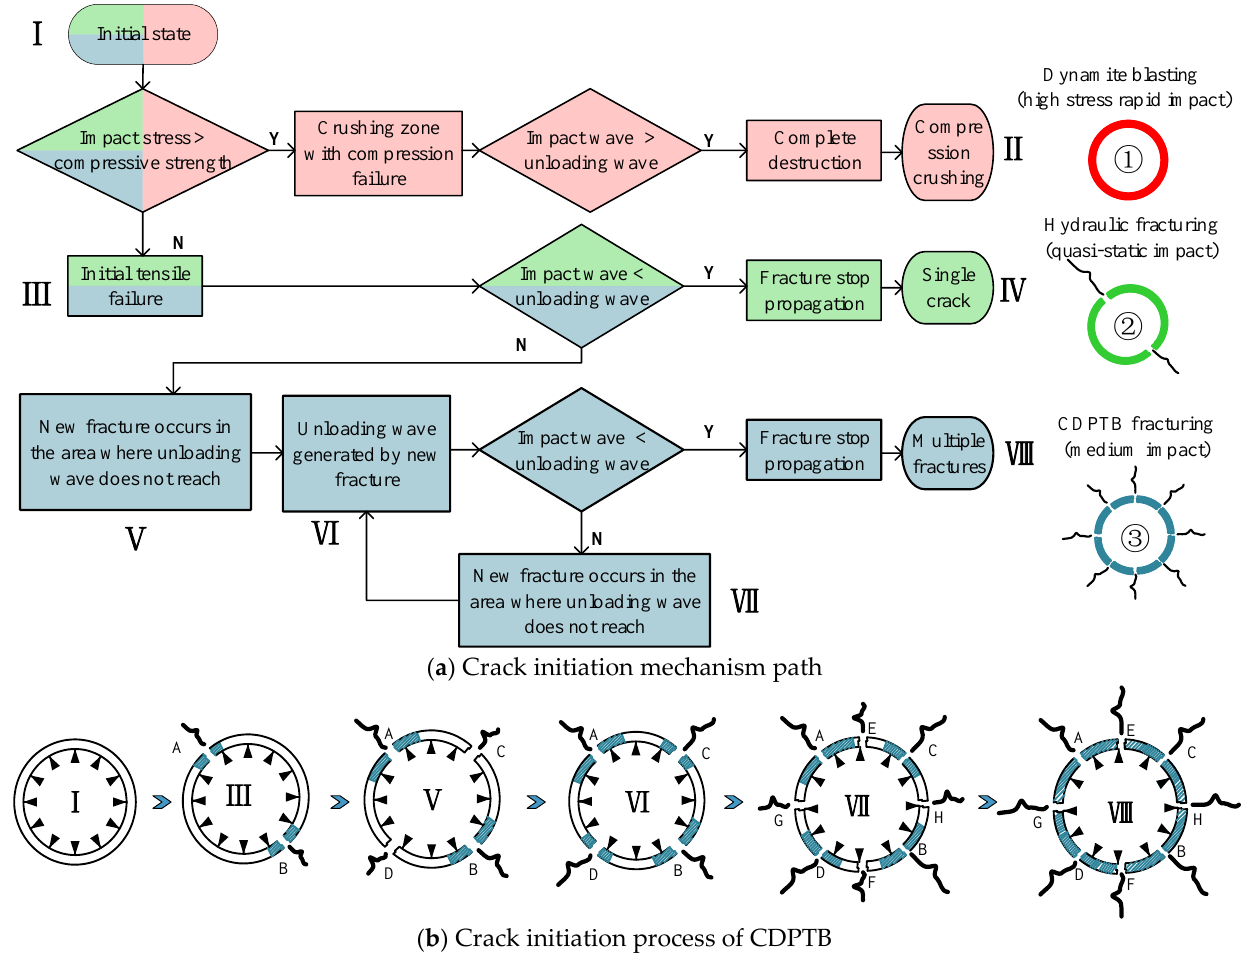
Figure 10. Initiation mechanism of phase change impact stress. 1 (cid:13) The core of different fracture forms is the difference of shock wave propagation rate and stress peak. When the impact stress is large and the rate is fast, the stress directly exceeds its compressive strength, and the coal body is compressed and destroyed. At the same time, the impact rate is fast, and the coal rock body is completely destroyed before the unloading wave is fully formed. The unloading wave cannot form an effective unloading effect (I → II), and a crushing fracture zone is formed around the borehole. 2 (cid:13) As the peak value of impact stress decreases, the dynamic compressive strength